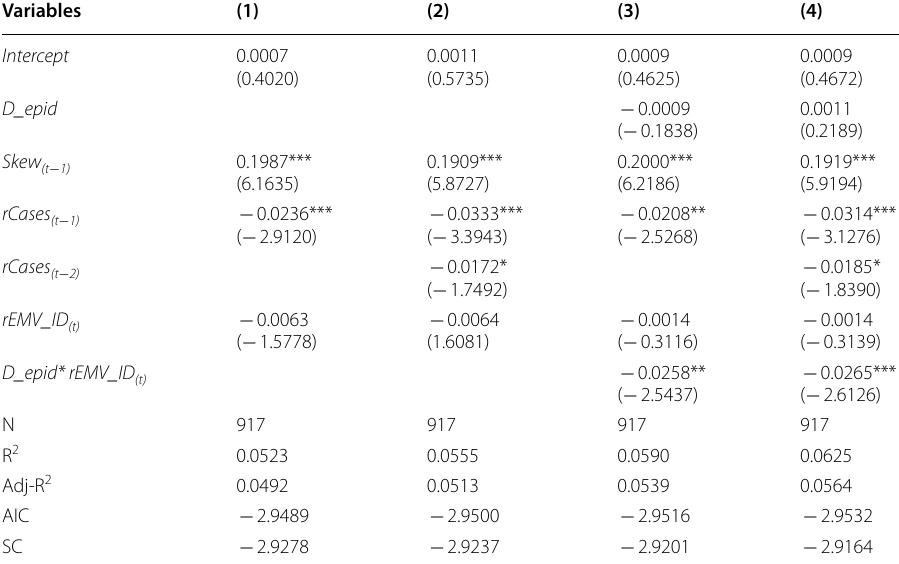
Table 9 Robustness results from